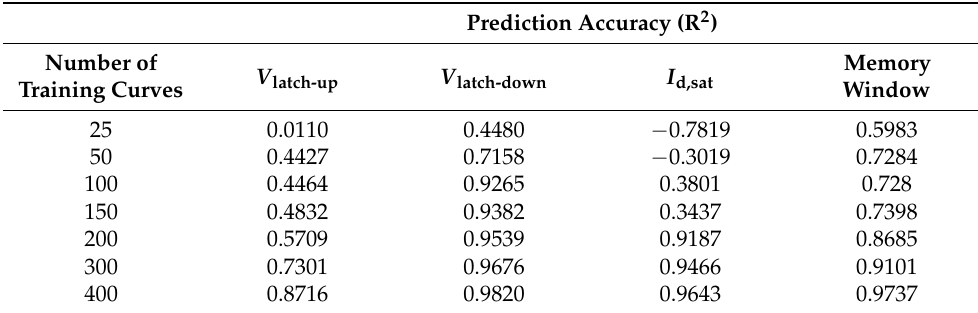
Table 2. Prediction accuracy as a function of the number of I-V curves in the dataset for the prediction of device characteristics.